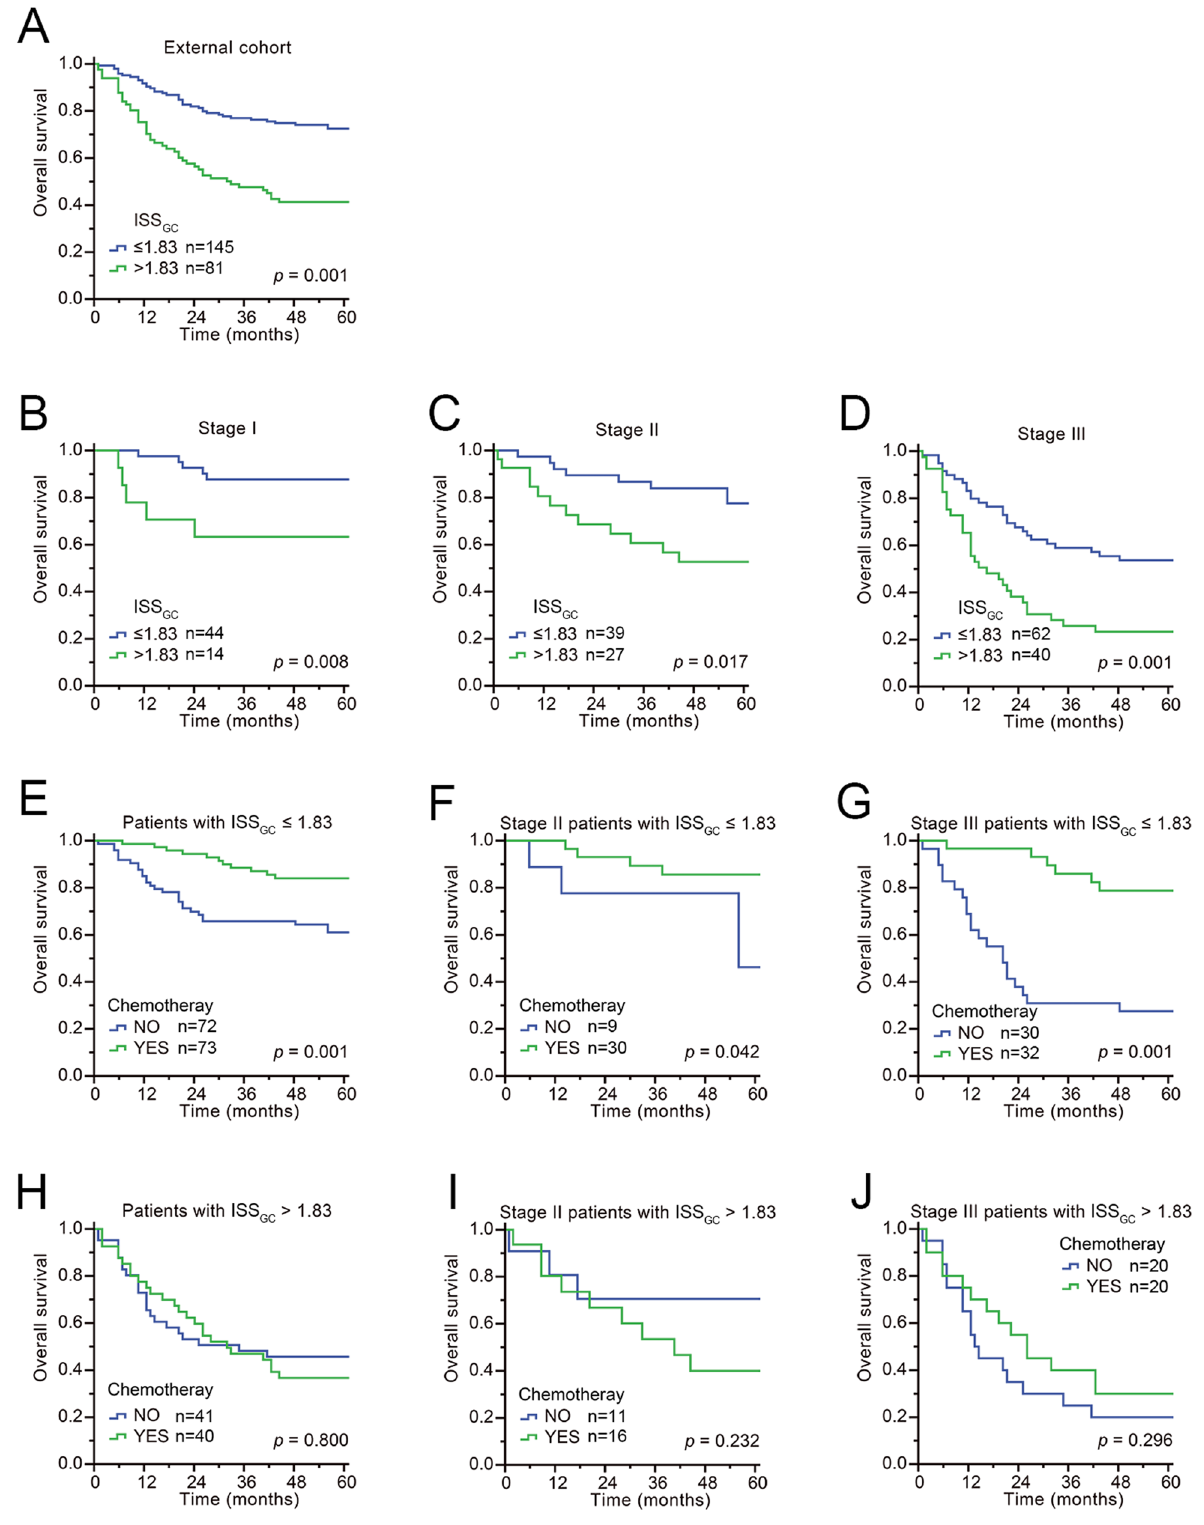
Fig. 7 External veri fi cation. A The overall survival according to the ISS GC was validated in external cohorts using Kaplan – Meier curves. B – D The overall survival according to TNM stage after strati fi cation by ISS GC in patients from external centres was similar to that in patients from our centre. E – J The overall survival based on receipt of chemotherapy and TNM stage after strati fi cation according to the ISS GC in patients from external centres was similar to that in patients from our centre. p -Values for survival analyses have been calculated using the log-rank